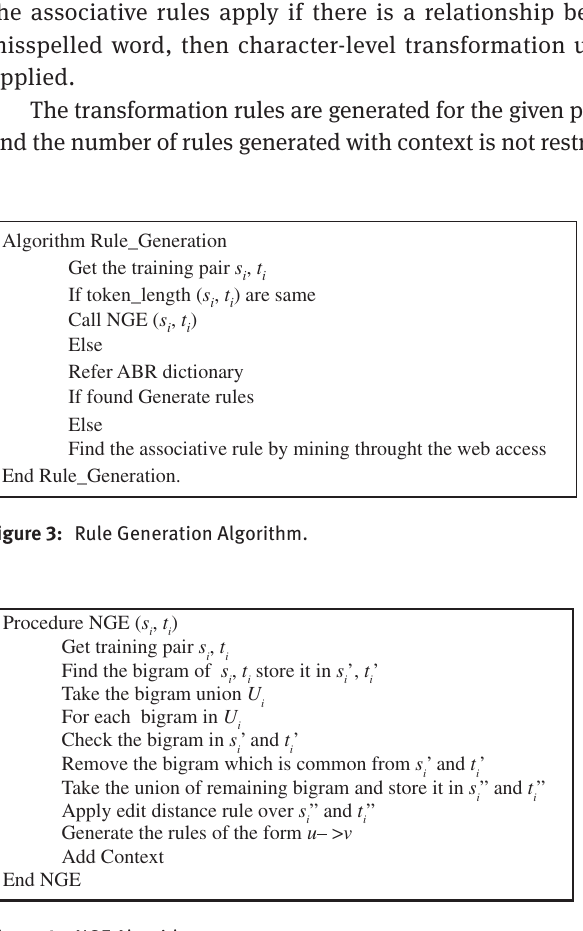
Figure 4: NGE Algorithm.